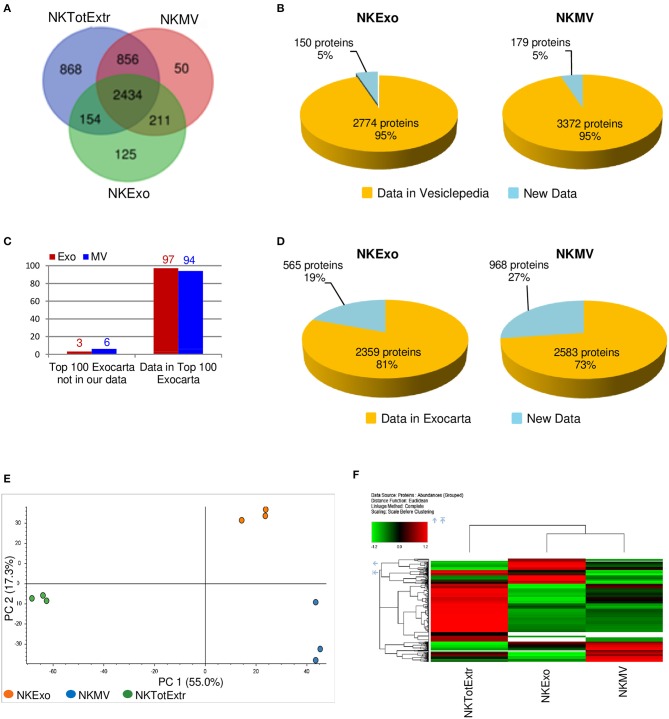
Proteomic analysis of proteins identified in natural killer (NK) cell total extract, NK-cell-derived microvesicle (NKMV) and NKExo. (A) Venn diagram of all identified proteins in NK cell total extract (TotExtr), NKMV, and NKExo. (B) Proteins identified in NKExo and NKMV samples compared with those present in Vesiclepedia database. (C,D) Proteins identified in NKExo (Exo) and NKMV (MV) samples compared with those present in the top 100 Exocarta (C) and in the whole Exocarta database (D). (E) Principal component analysis (PCA) of NKExo, NKMV, and TotExtr normalized protein abundances. (F) Hierarchical cluster analysis of the grouped abundances of NKExo, NKMV, and TotExtr scaled before clustering and using the euclidean function for the distance.